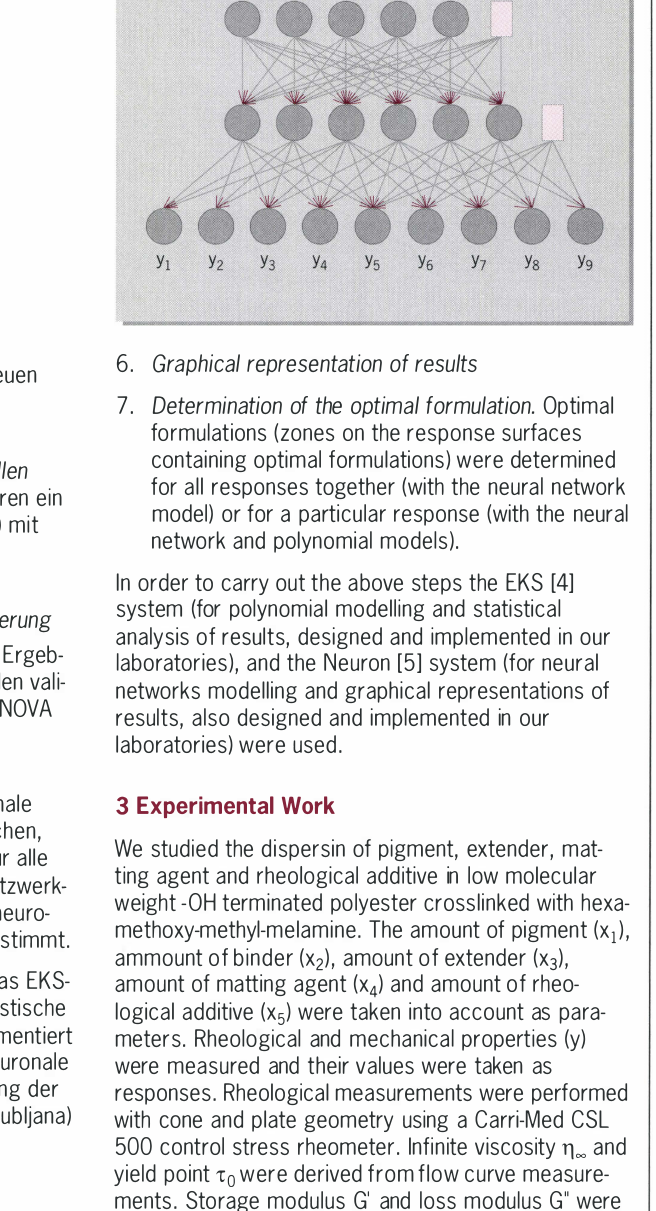
Fig: 1: The two-layer neural network used for modelling rheological properties. Connections between layers are not completely